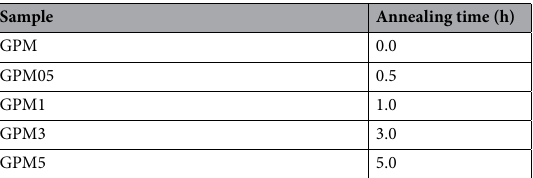
Table 1. Annealing times used in this work for the controlled crystallization of GPM sample (with 10 wt% of Nd